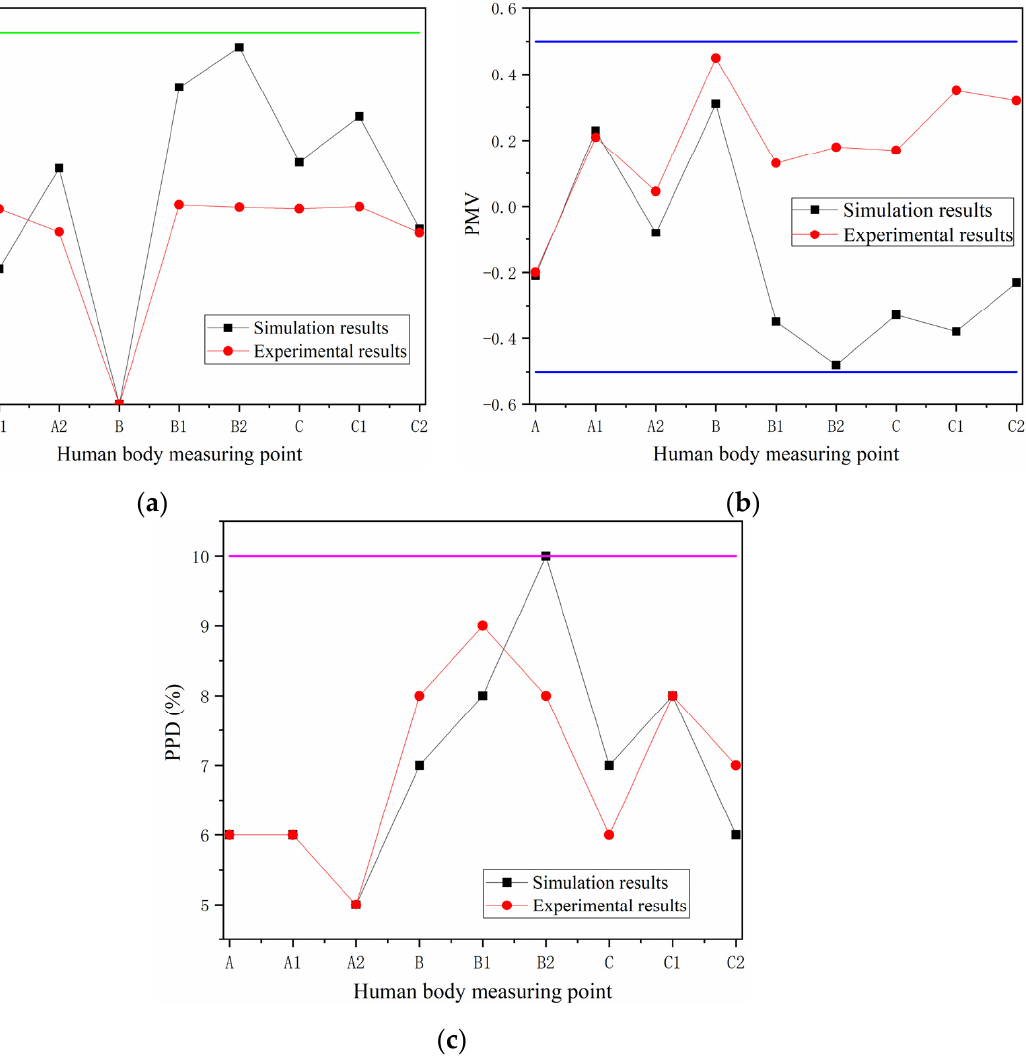
Figure 5. ( a ) The PD of various parts of the human body. ( b ) PMV of various parts of the human body. ( c ) PPD of various parts of the human body.